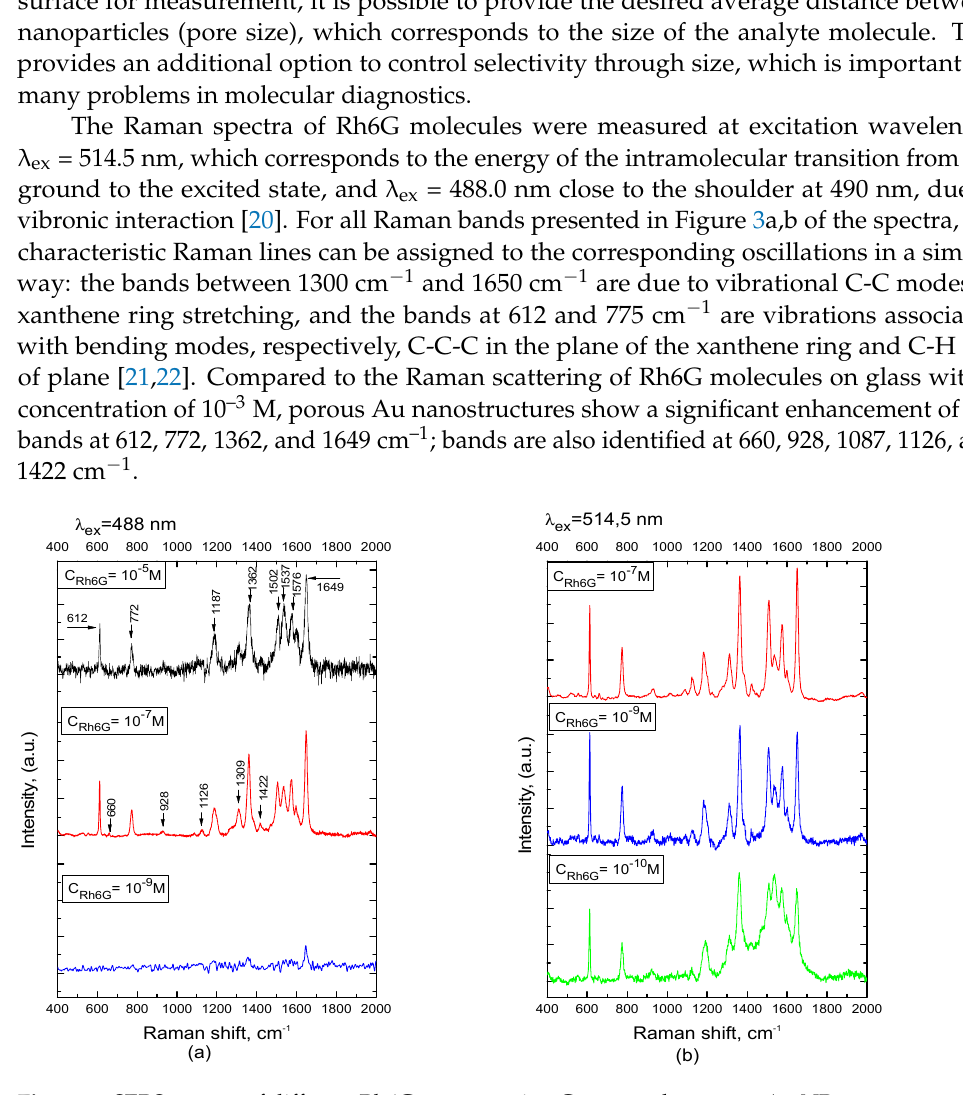
Figure 3. SERS spectra of different Rh6G concentration C Rh6G on the porous Au NP arrays measured on a region with d =15.2 nm at excitation wavelength λ ex = 488 nm-( a ), λ ex = 514.5 nm-( b ). Comparison of the Raman spectra obtained at different excitation wavelengths unambiguously indicates an increase in the intensity of the bands at λ ex = 514.5 nm by a factor of 2 at a Rh6G concentration of C Rh6G = 10 − 7 M and by a factor of 15 for C Rh6G = 10 − 9 M. It should be noted that the low detection limit for Rh6G upon excitation at 488 nm is only ca. 10 − 9 M, which is due to the features of the Raman amplification mechanism beyond the plasmonic band. The differences in the Raman spectra also indicate that the amplification mechanisms are somewhat different in these spectral ranges.